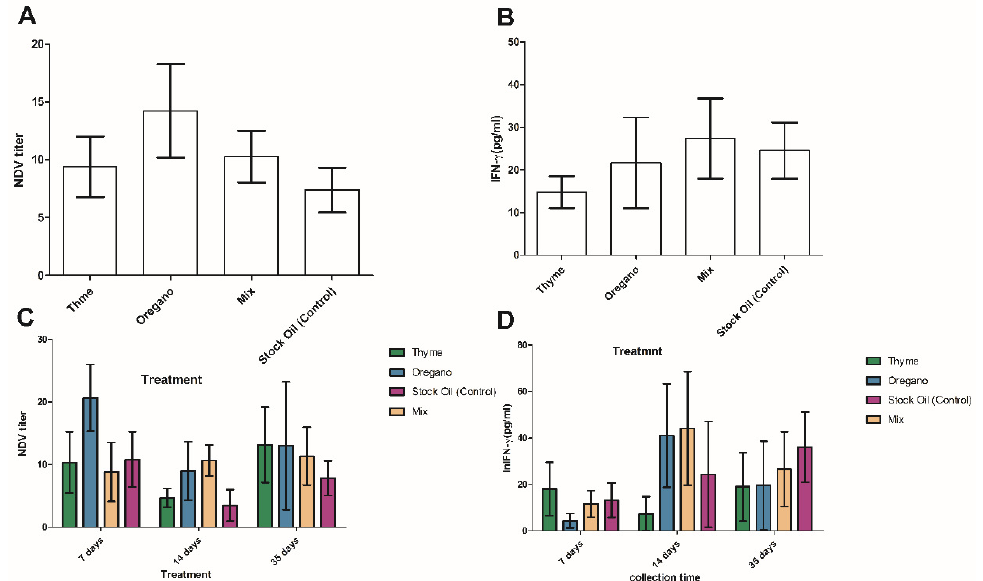
Table 4. The effects of muscle abnormalities (normal, white striping (WS), and white striping combined with wooden breast condition (WS and WB)) on the color traits (L*, a*, and b*), pH, and breast weight. Normal WS WS and WB p Value M ± STD M ± STD M ± STD L* value * 70.15 ± 4.45 69.22 ± 8.63 67.60 ± 5.55 0.20 a* value * 2.51 ± 1.45 1.83 ± 1.28 2.02 ± 0.79 0.11 b* value * 4.25 ± 1.62 3.73 ± 1.19 4.52 ± 1.64 Breast weight (g) 189.0 ± 38.8 a 205.9 ± 30.0 ab 213.2 ± 30.9 b <0.05 Data are reported as means (M, n = 21/group) and standard deviations (STD). Different letters in the same row indicate significant differences ( p < 0.05). The levels of white striping (WS) were classified as normal, moderate, or severe according to Kuttappan et al. [27]. * The color trait (CIE L* = lightness, a* = redness, and b* = yellowness). Dietary supplementation with thyme or oregano essential oils alone or a mixture had no significant ( p < 0.05) positive effects on the broilers’ humoral or cellular immune reac- tions to NDV treatments (Figure 2). No significant effects were found for the treatments on the weekly and accumulative NDV Ab titers and IFN- γ levels of chicks during the experimental period (Figure 2).